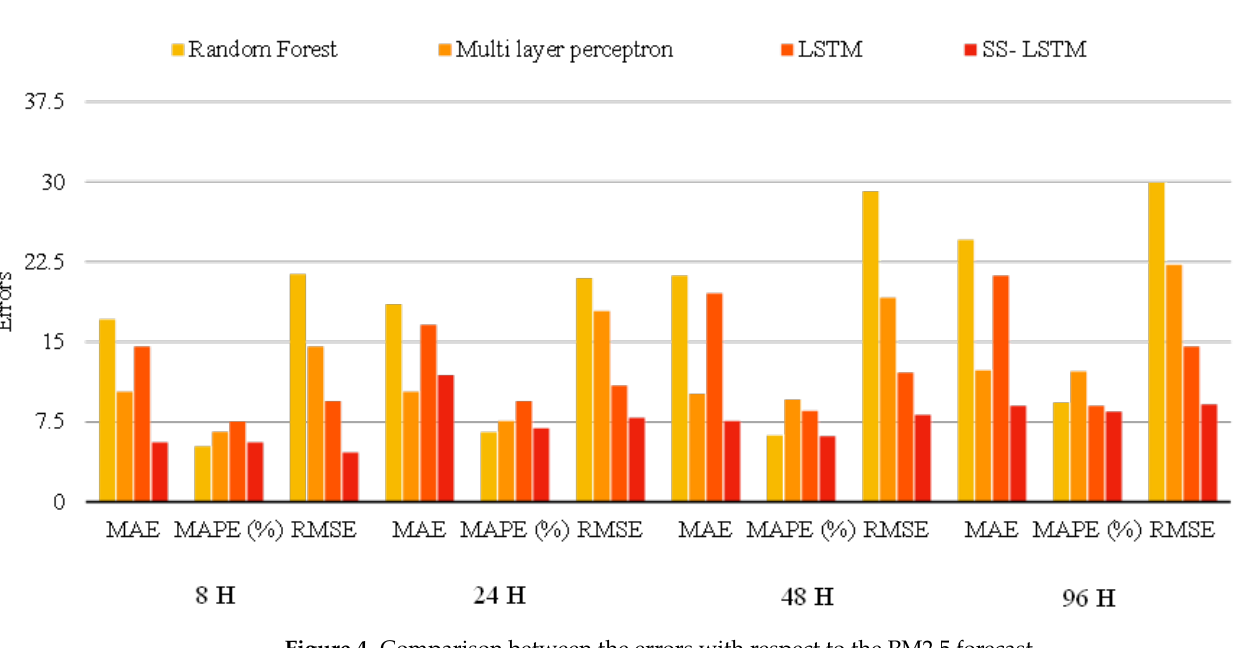
Figure 4. Comparison between the errors with respect to the PM2.5 forecast.